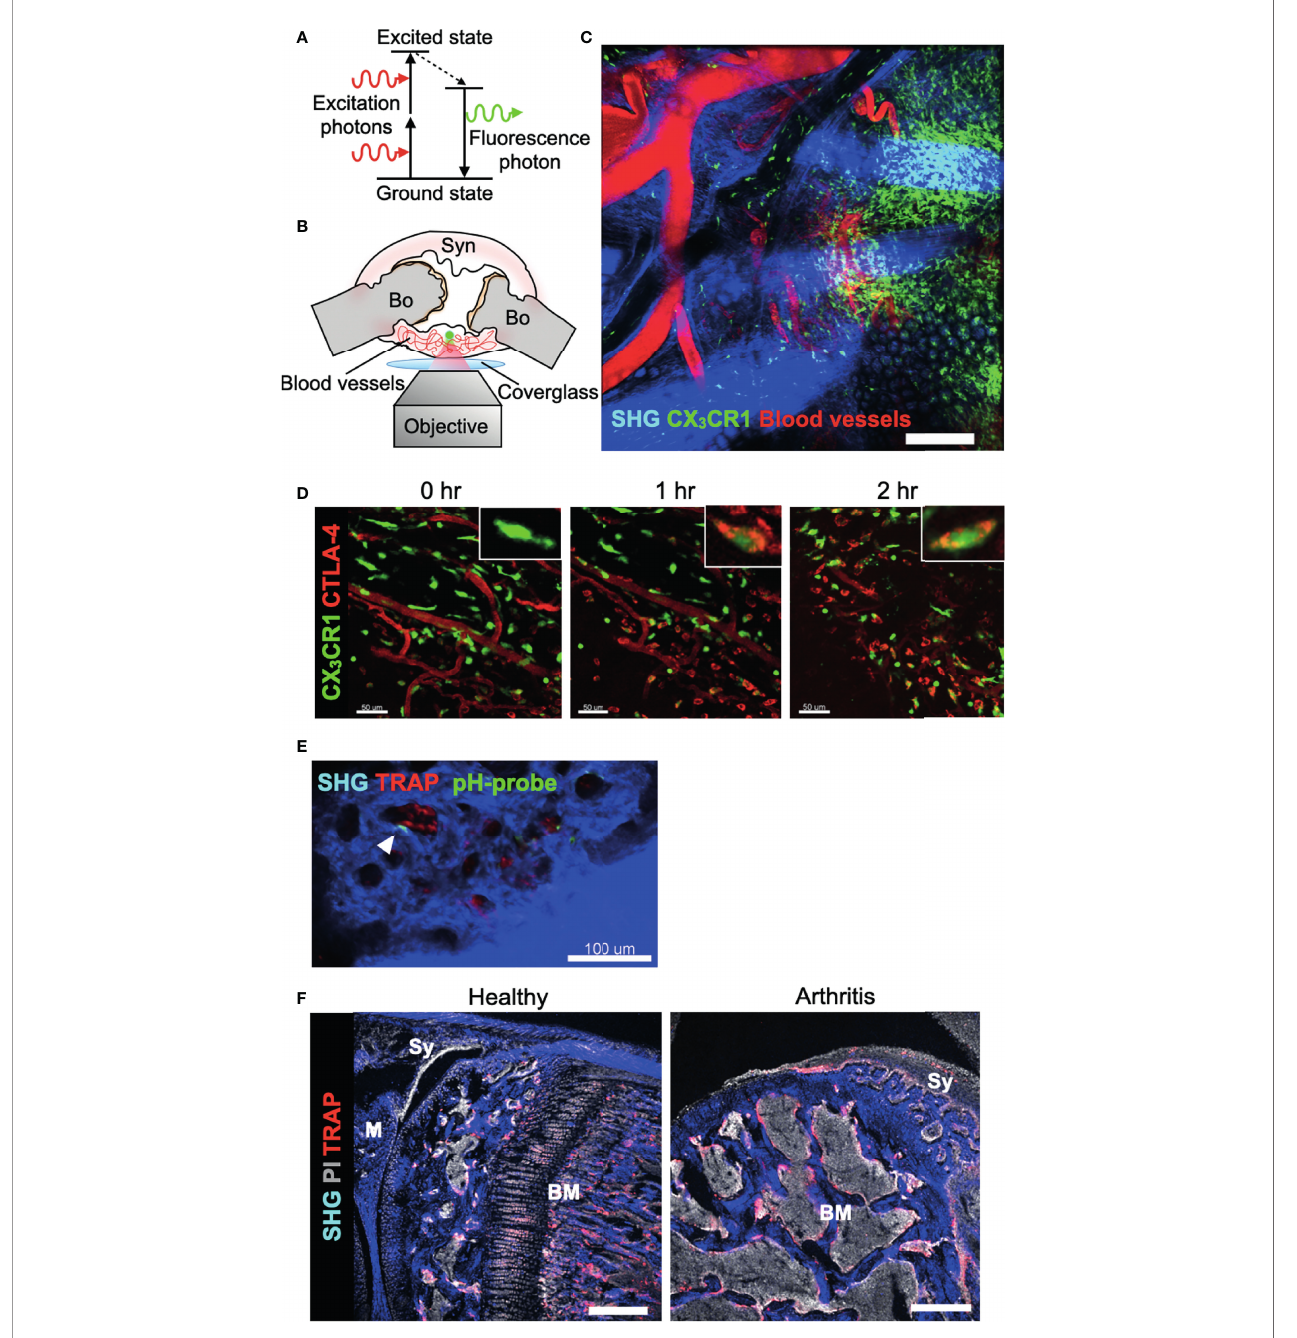
FIGURE 2 | Real-time imaging of the synovium in vivo using multi-photon microscopy. (A) Basic mechanism of two-photon excitation. Two-photon excitation occurs when a fl uorophore absorbs two photons simultaneously. Each photon possesses about half of the energy required to excite the fl uorophore. (B) Schematic of preparation of exposed synovium, with a coverglass and microscope objective positioning. The green dot shows the area of two-photon excitation. Bo, Bone; Syn, synovium. (C) Tile scan image of the in fl amed synovium of CX 3 CR1-EGFP transgenic mice taken by two-photon microscopy. Blood vessels are visualized via intravenous injection of CTLA-4 Ig labeled with AF647 (red). Collagen fi bers are visualized by second harmonic fl uorescence generated from two-photon excitation (blue). Scale bar: 200 m m. (D) Time-lapse imaging of the in fl amed synovium of CX 3 CR1-EGFP transgenic mice. Intravenously injected CTLA-4 Ig (red) extravasates and binds to CX 3 CR1 + macrophages (green) after one hour. Scale bars: 50 m m. The MIPs of two-dimensional image stacks of vertical synovial slices are shown. (E) Intravital images of the third meta phalangeal joint of the CIA TRAP-tdTomato transgenic mice (red) after pHocas-3 (green) injection. Bar, 100 m m. (F) Propidium iodide (PI) and TRAP staining fl uorescence were visualized by single-photon excitation, while second harmonic generation was produced by two-photon excitation to visualize the bone tissue of the knee joint section. Scale bar: 300 m m. BM, bone marrow; M, meniscus; Sy,